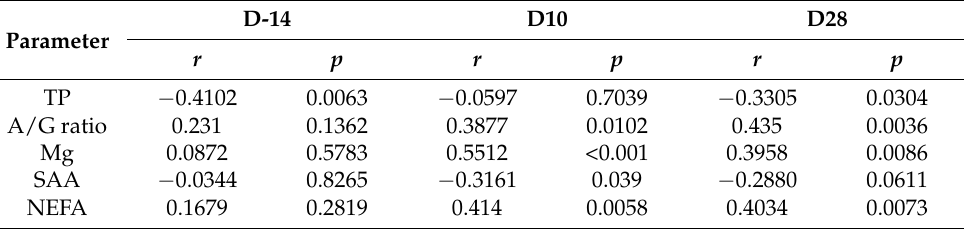
Table 1. Pearson’s correlation coefficients (r) for relationships between the AMH ratio (AMH at D28/AMH at D-14) and biochemical and inflammation parameters with significant correlations in all 43 cows